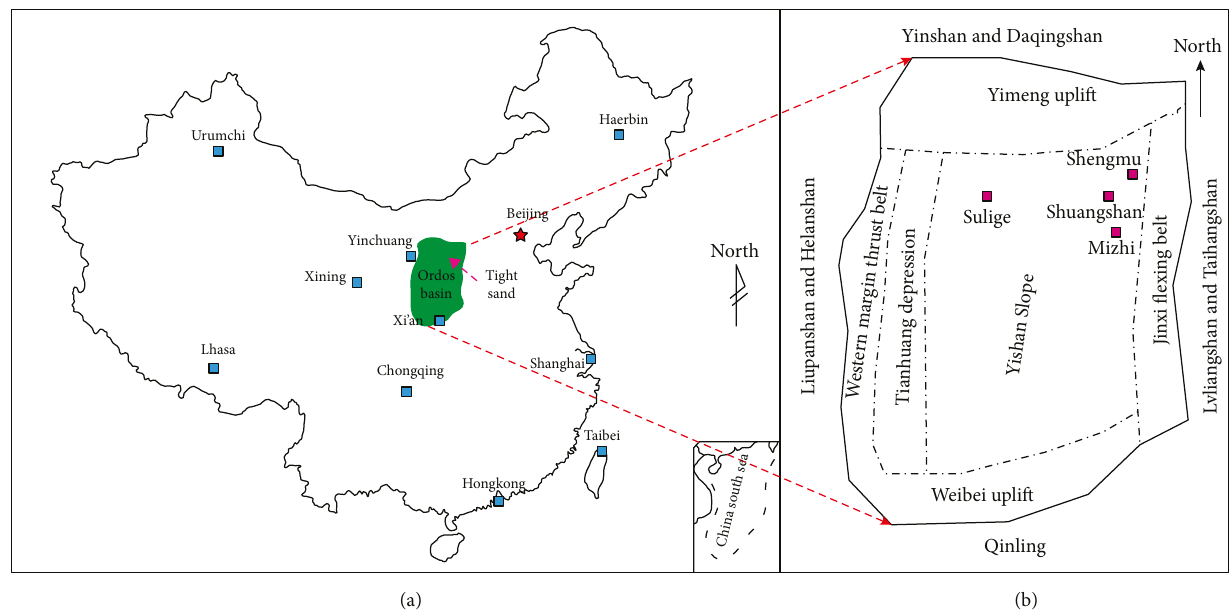
Figure 1: The simple map of the study area. (a) China map; (b) the ampli fi cation map of the green part in